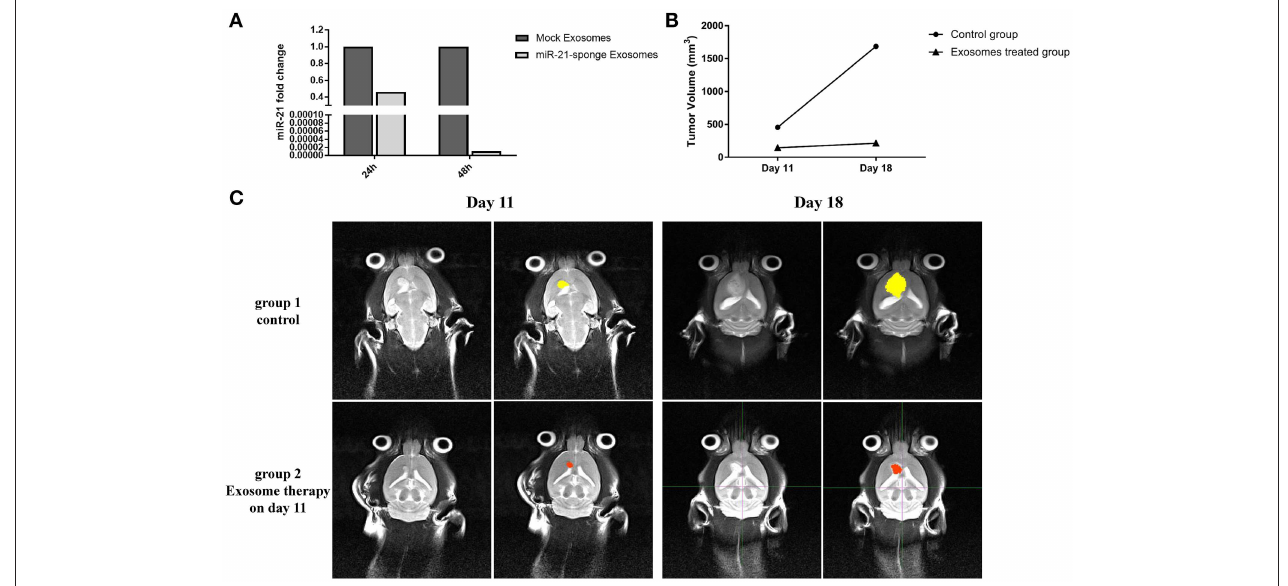
FIGURE 7 | In vivo analysis results: (A) Downregulation of miR-21 in the C6 cells treated with exosomes enriched with miR-21-sponge at 24 and 48h in comparison with cells treated with exosomes obtained from mock-vectors transfected HEK-293T stable cell lines observed. (B) Tumor volume graph on day 11 and 18 after stereotaxically injecting 1 million C6 cells at CPu position on rat brains. The exosomes treated group received about 15 µ g exosomes enriched with miR-21-sponge on day 11 and control groups had no treatment. (C) MRI pictures from two rats on day 11 and 18 from. The exosomes treated rat’s tumor had growth inhibition on day 18 in comparison with control rat.